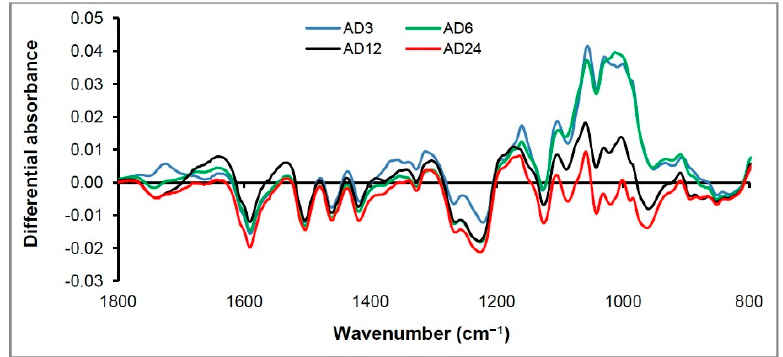
Figure 14. Differential FTIR spectra of black locust samples.